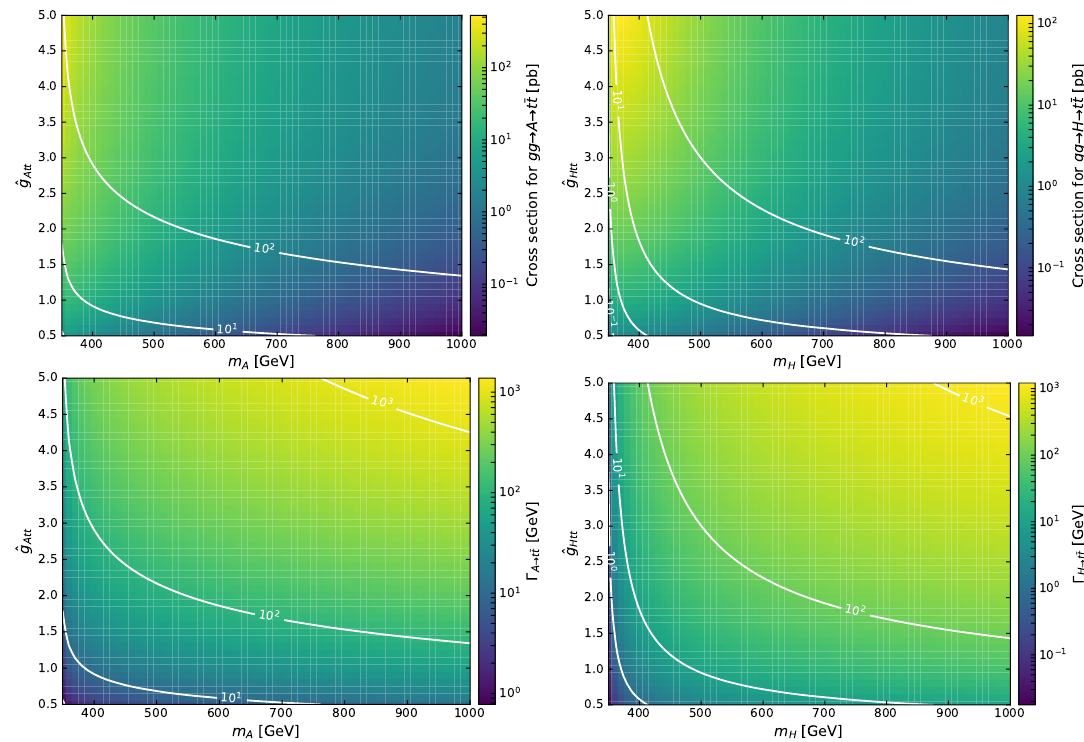
Figure 4 . The gg ! (cid:8) ! t (cid:22) t production cross sections at the 13 TeV LHC and the decay